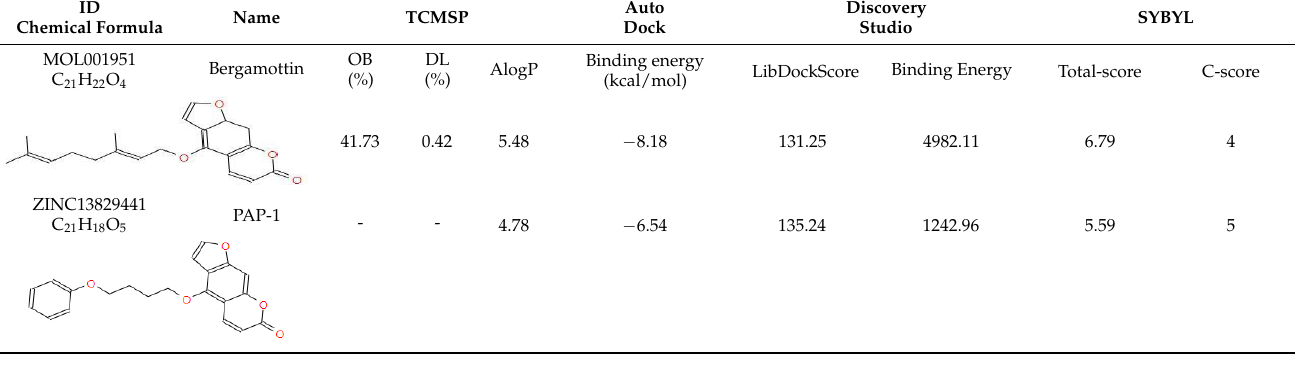
Table 1. Bergamottin and PAP-1 docking parameters.